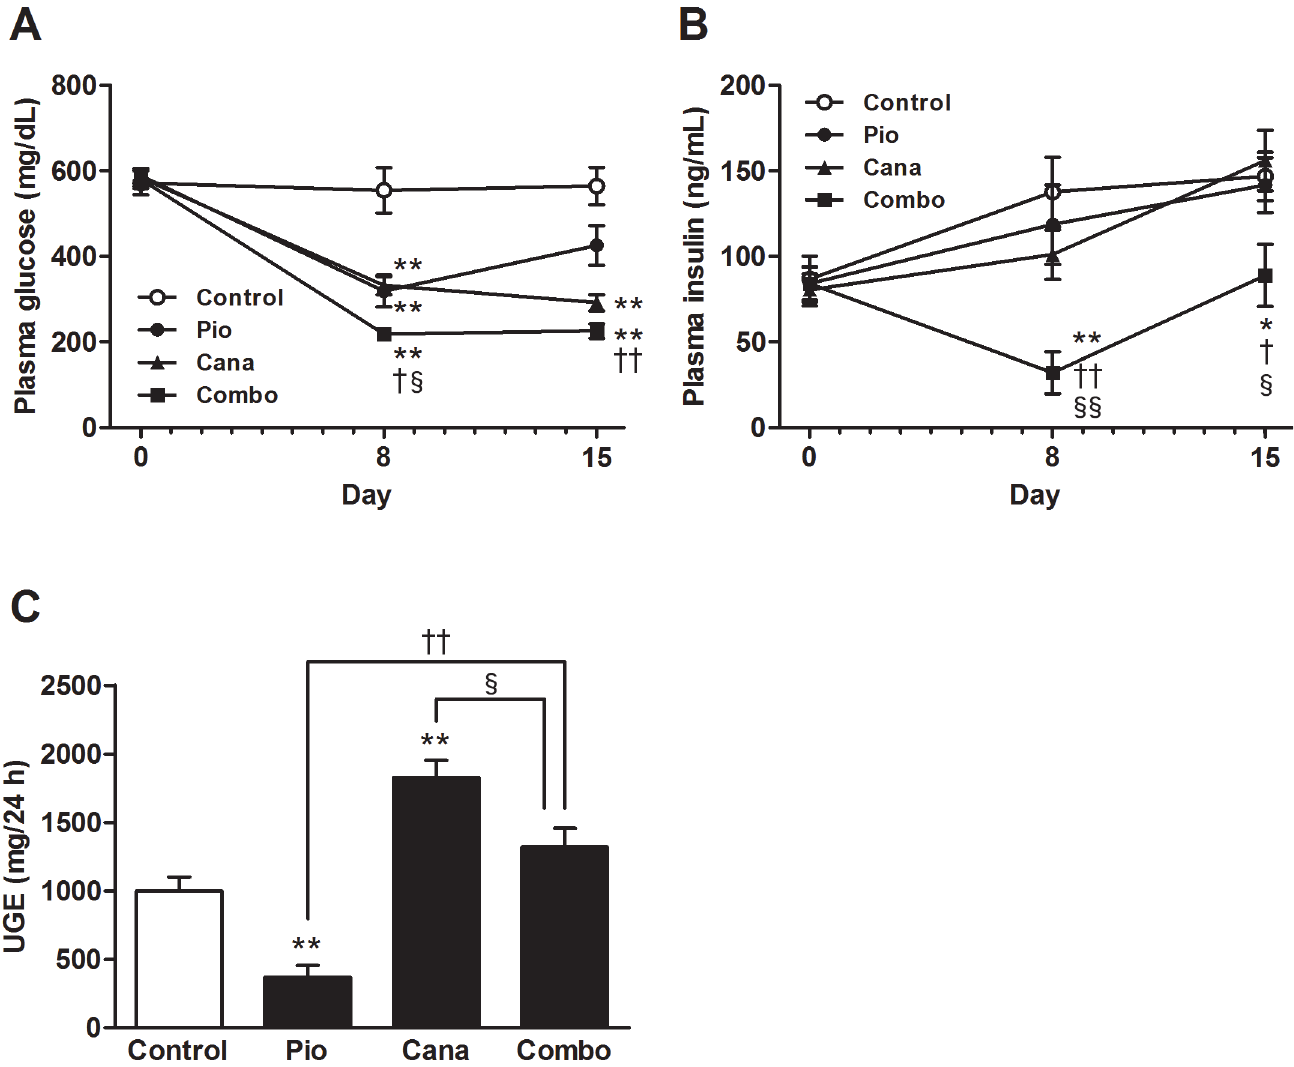
Figure 1. Glycemic control and urinary glucose excretion (UGE) in KK-A y mice. A: Plasma glucose, B: Plasma insulin, and C: UGE. Canagliflozin (Cana; 0.01% w/w food admixture), pioglitazone (Pio; 0.01% w/w food admixture), and their combination (Combo) were administered for 2 weeks. UGE was measured on days 14 – 15. Data are expressed as mean ± SEM (n = 7 – 8). * P < 0.05, ** P < 0.01 vs. control, † P < 0.05, †† P < 0.01 vs. Pio, § P < 0.05, §§ P < 0.01 vs.